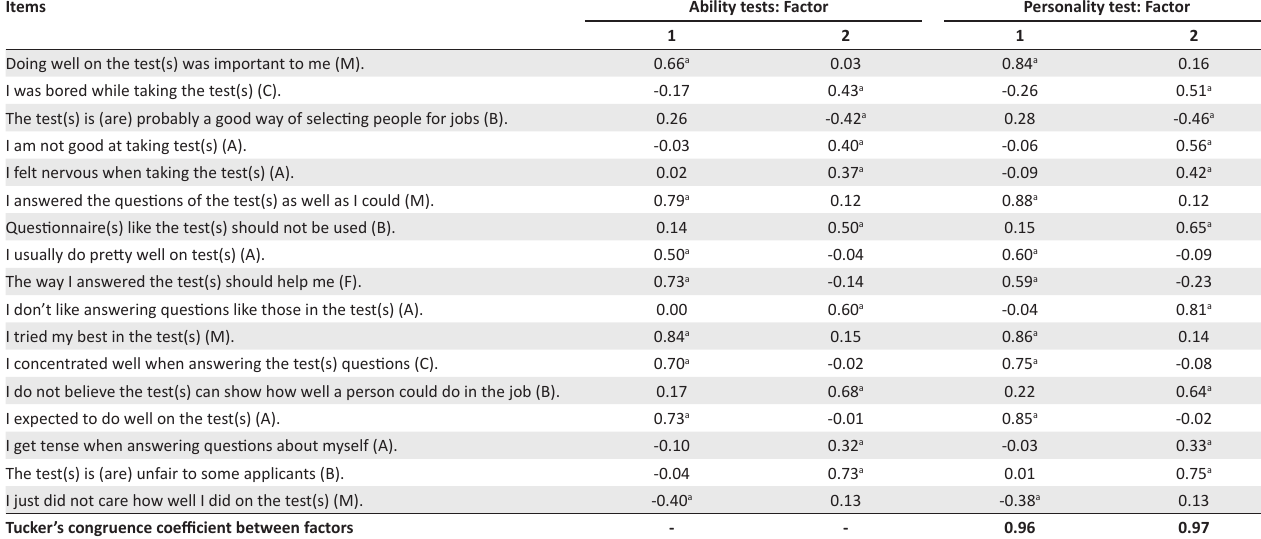
TABLE 2: Rotated factor pattern matrix and congruence coefficients for the Test Attitude Survey – an adapted version of the measure. Items Ability tests: Factor Personality test: Factor